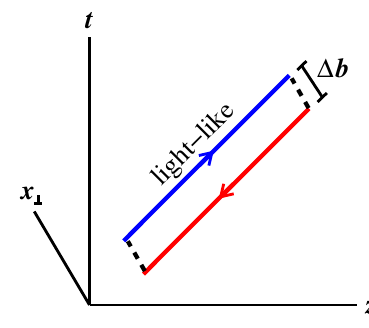
Figure 6 . A Wilson loop with transverse separation ∆ b and long, light-like